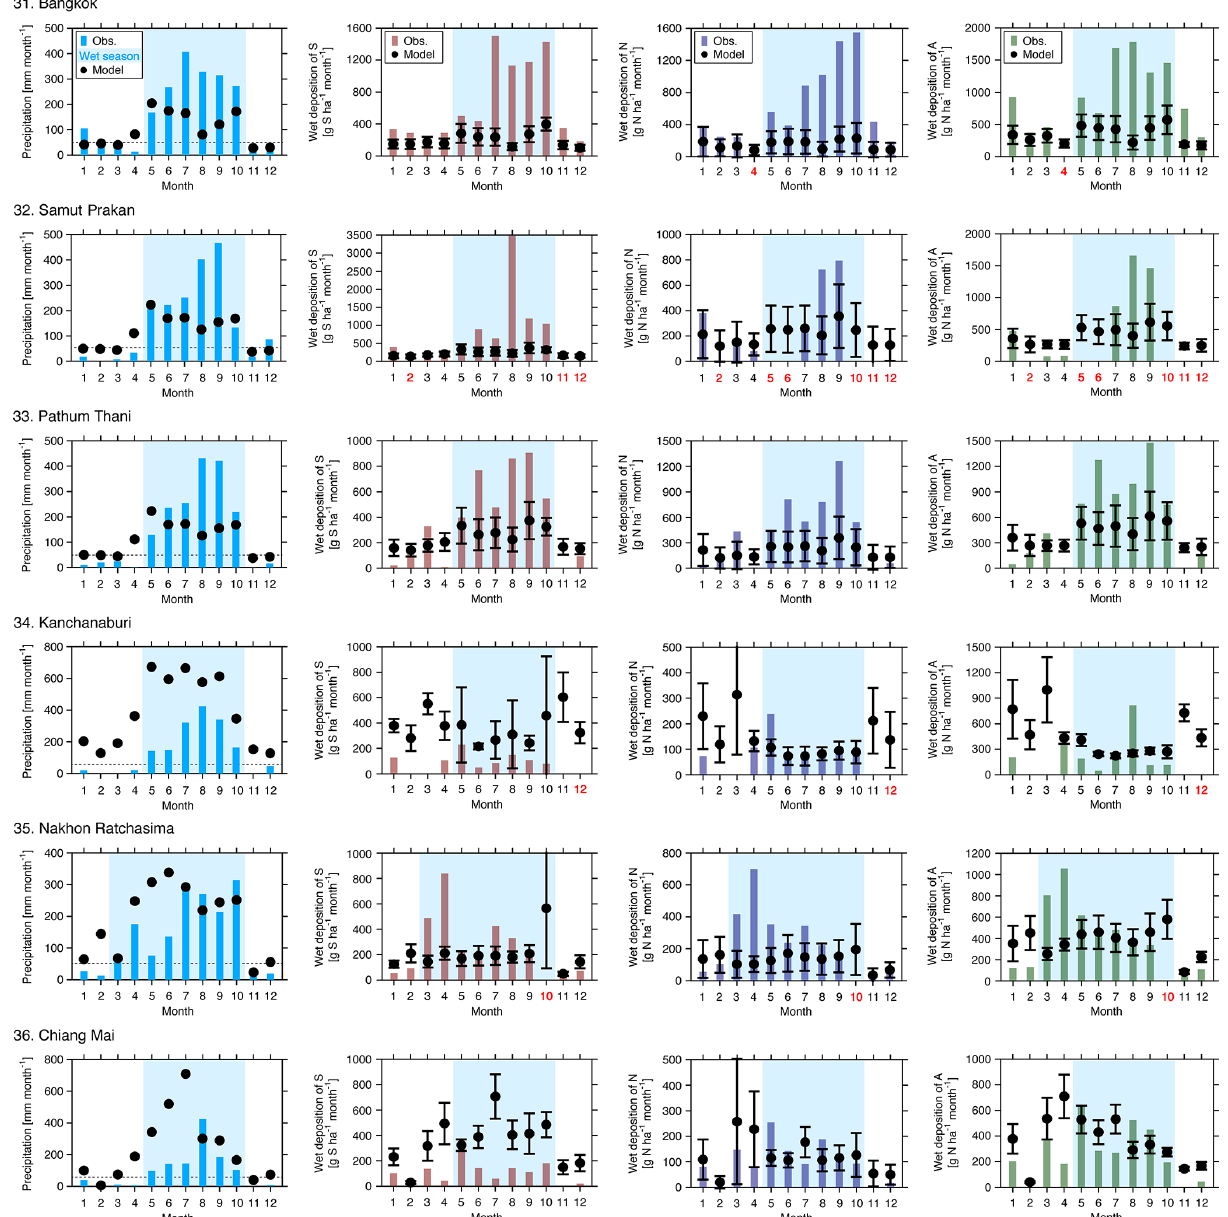
Figure 3. Monthly accumulated precipitation and wet depositions of S, N, and A over Thailand. Whiskers represent the standard deviation among the seven models, and the wet season (light blue color) is defined as months when precipitation exceeded 50mm. Months shown in red indicate a lack of observational